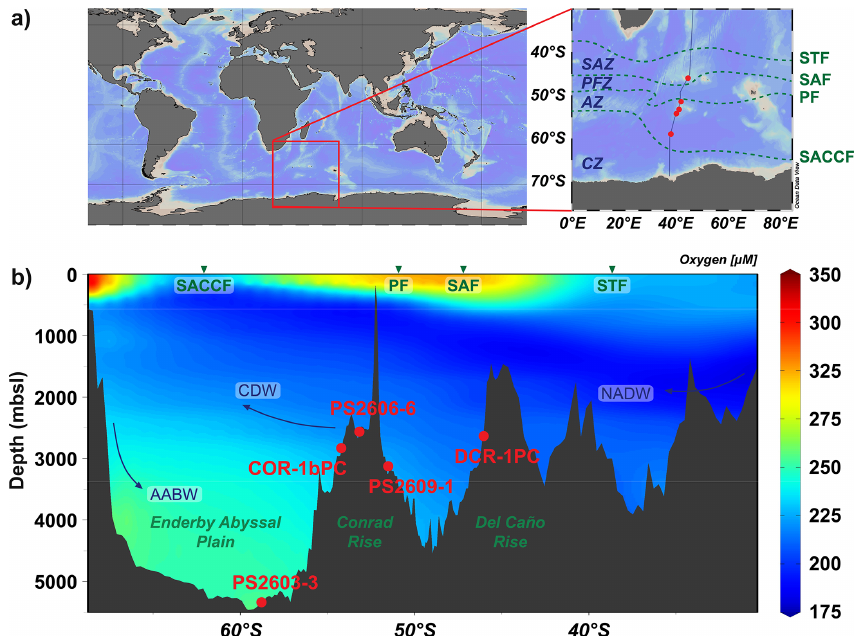
Figure 1. (a) Core locations in the SW Indian Ocean across the Southern Ocean frontal system. The fronts from north to south are the Subtropical Front (STF), Subantarctic Front (SAF), Polar Front (PF), and the Southern Antarctic Circumpolar Current Front (SACCF). The zones between them are defined as the Subantarctic Zone (SAZ), Polar Frontal Zone (PFZ), Antarctic Zone (AZ), and Continental Zone (CZ) (Orsi et al., 1995). (b) Cross section of core locations with modern oxygen concentrations (plotted with the ODV software, Schlitzer, 2018).